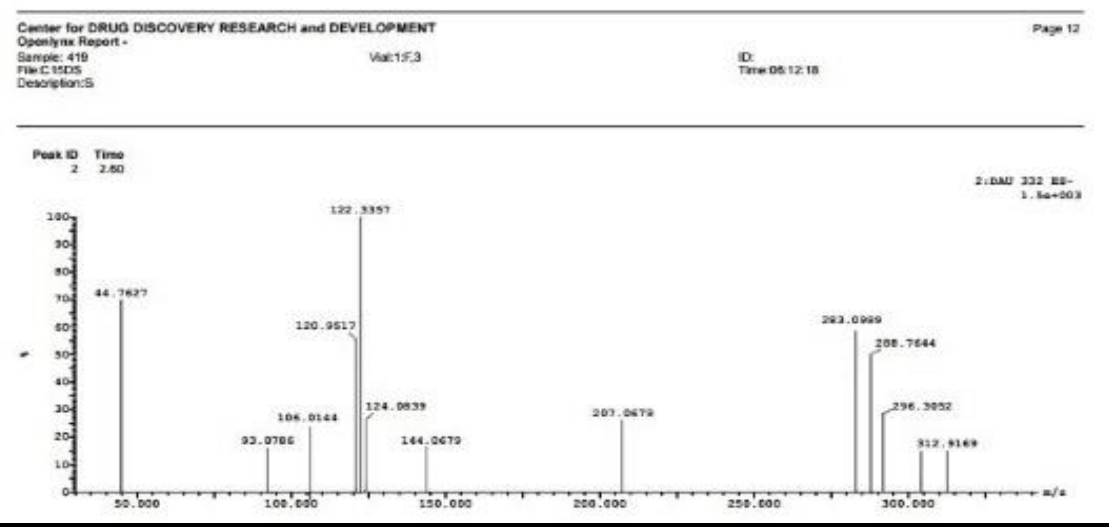
Figure 15 .Mass fragmentation of